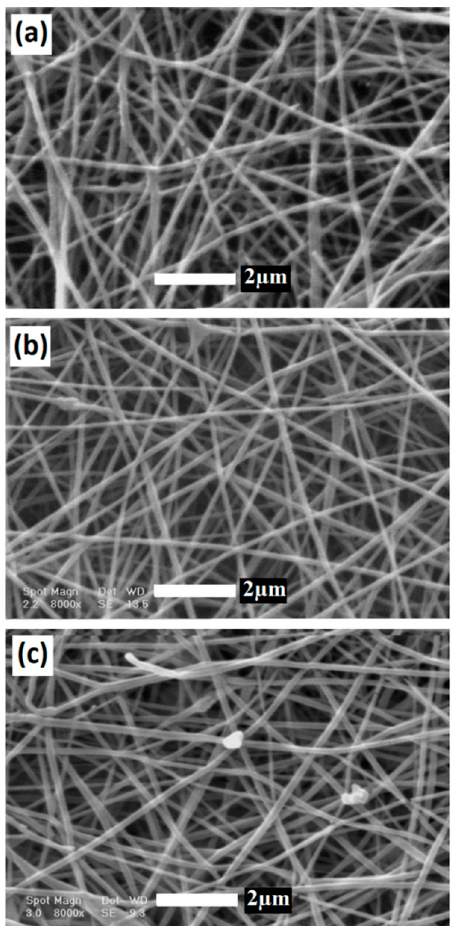
Figure 1. SEM micrographs of ( a ) 1BG/GE/PCL, ( b ) 3BG/GE/PCL and ( c ) 5BG/GE/PCL composites.